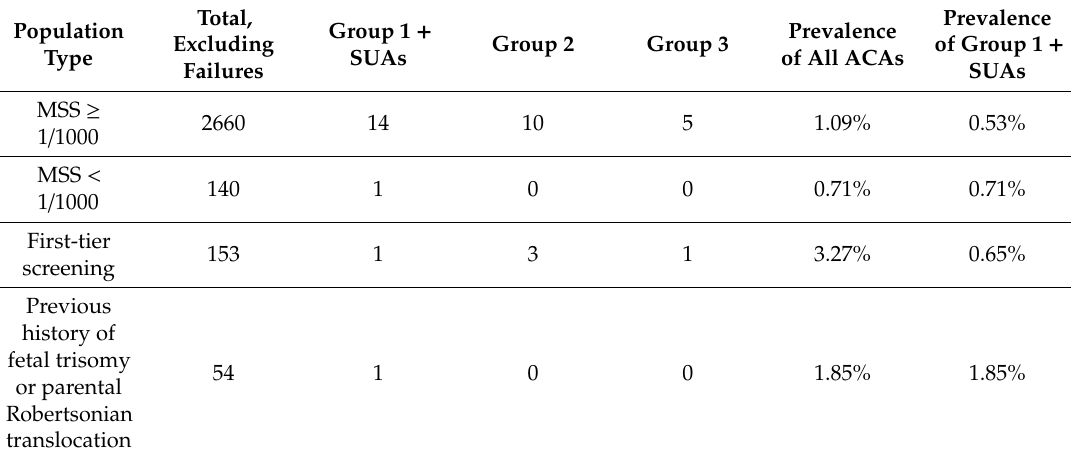
Table 7. ACAs in the referral population according to NIPT